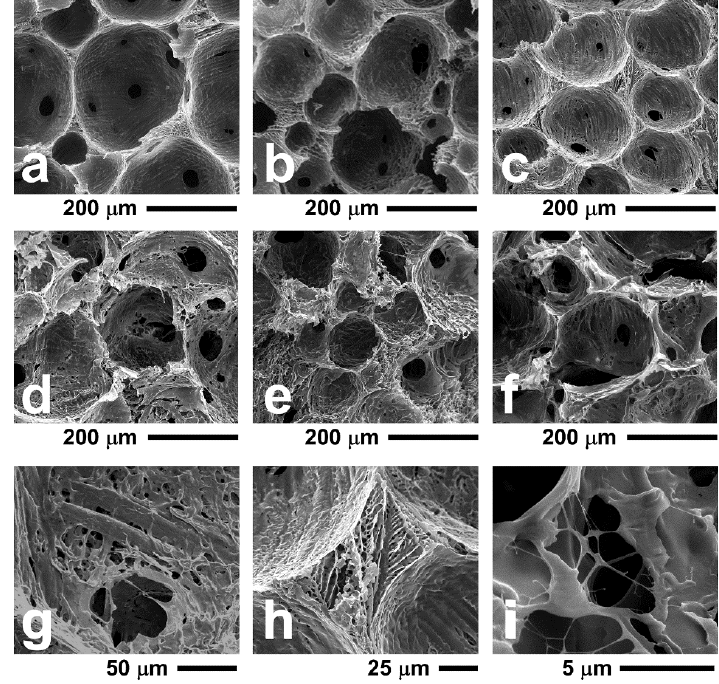
Figure 3. SEM micrographs of: ( a ) neat PVA foam; ( b ) PVA-MFC5; ( c ) PVA-MFC10; ( d ) PVA-MFC30; ( e , g , h , i ) PVA-MFC40; ( f ) PVA-WPC40.